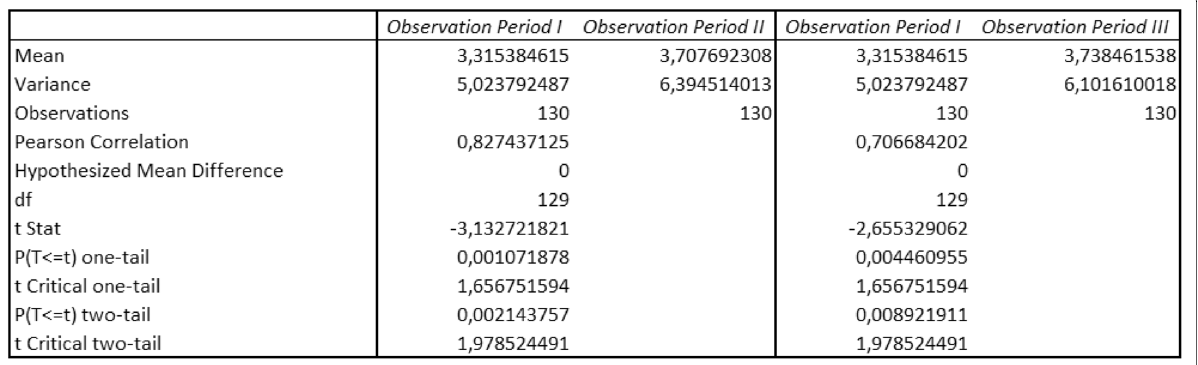
Fig. 3 t-Test Results of a Paired Two Sample for Means—Number of Disclosed Environmental